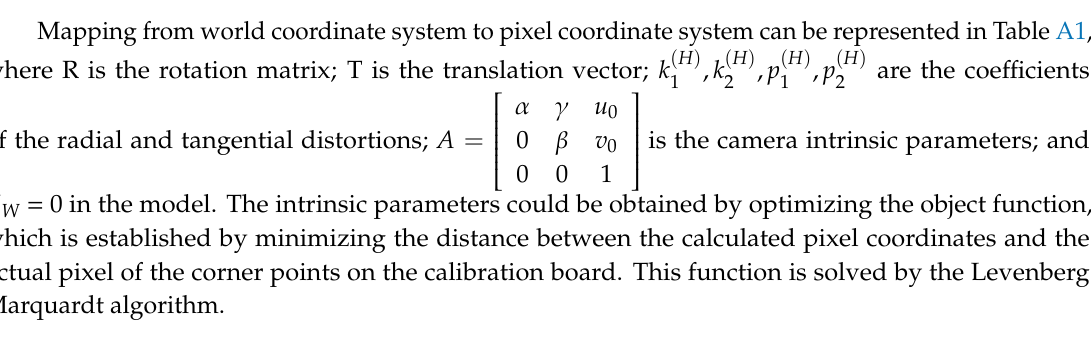
Figure A1. The imaging model of the camera.